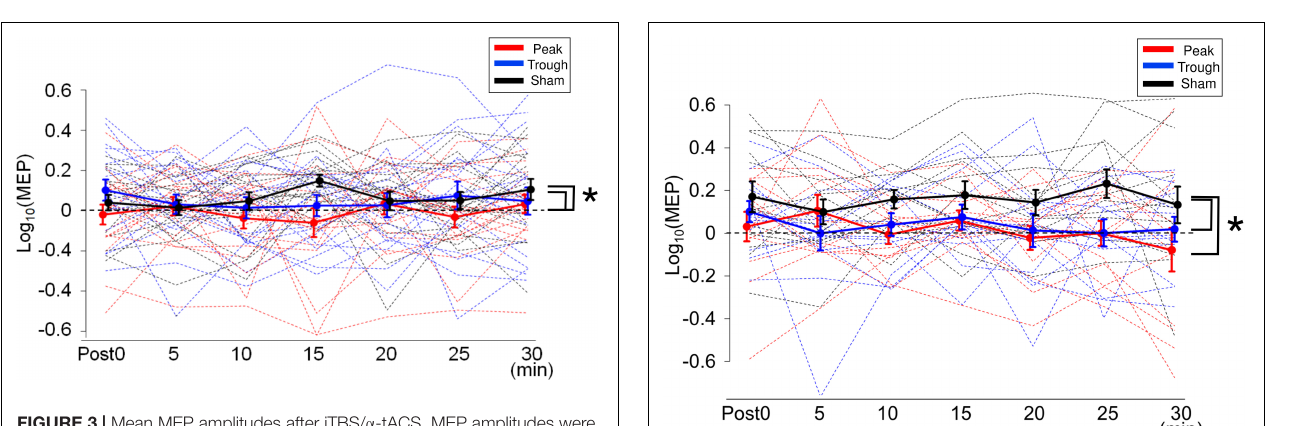
FIGURE 3 | Mean MEP amplitudes after iTBS/ α -tACS. MEP amplitudes were log-transformed and normalized by the baseline amplitudes. Accordingly, positive values indicate enhancement after the stimulation while negative values imply MEP suppression. Thick solid lines represent mean amplitudes while dotted lines indicate the MEP amplitudes for each subject. MEP amplitudes after the sham and trough conditions were enhanced continuously after stimulation, while those after the peak condition were often suppressed. Accordingly, MEP amplitudes for the peak condition were lower than those for the sham and trough conditions. Error bars indicate standard errors of the mean (SEM). * p < 0.05.